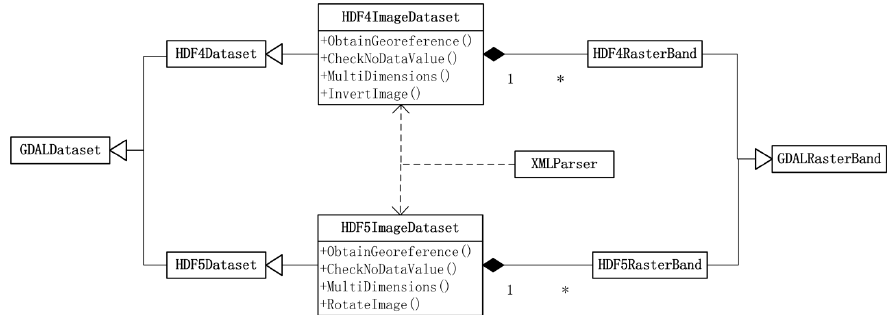
Figure 10. Implementation of the plug-in framework in Geospatial Data Abstraction Library (GDAL) source code. One HDF4/HDF5 image dataset (represented as 1 next to the solid diamond) includes multiple HDF4/HDF5 bands (represented as * oppose to 1).